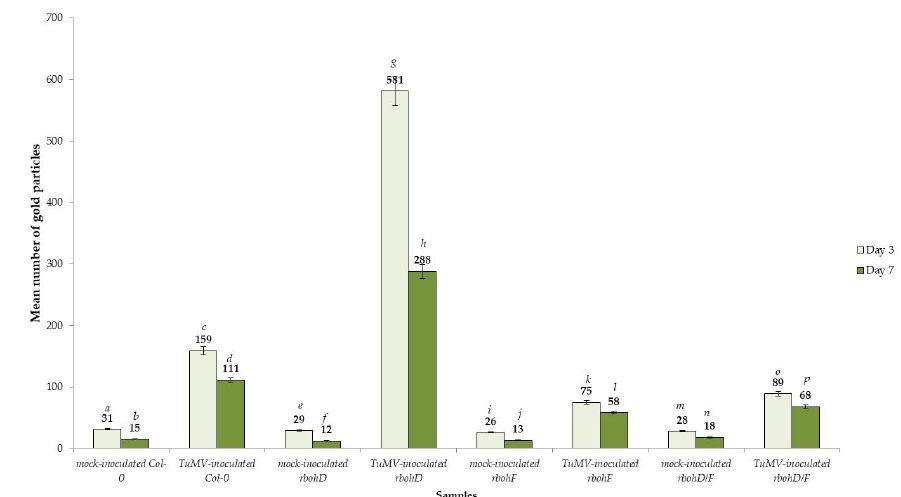
Figure 11. Quantification of PR1 antigen localization in mock- and TuMV-inoculated Arabidopsis thaliana Col-0, rbohD , rbohF and double rbohD/F mutant at 3 and 7 days after inoculation. Significant differences between classes at p < 0.05 level of significance by ANOVA with post-hoc Tukey HSD were assessed. The statistical significant values are marked by letters above chart